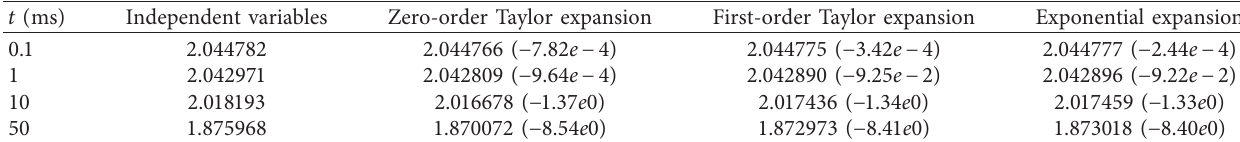
Table 4: TWIGL relative power transient reference problem step reactivity insertion at 50ms.